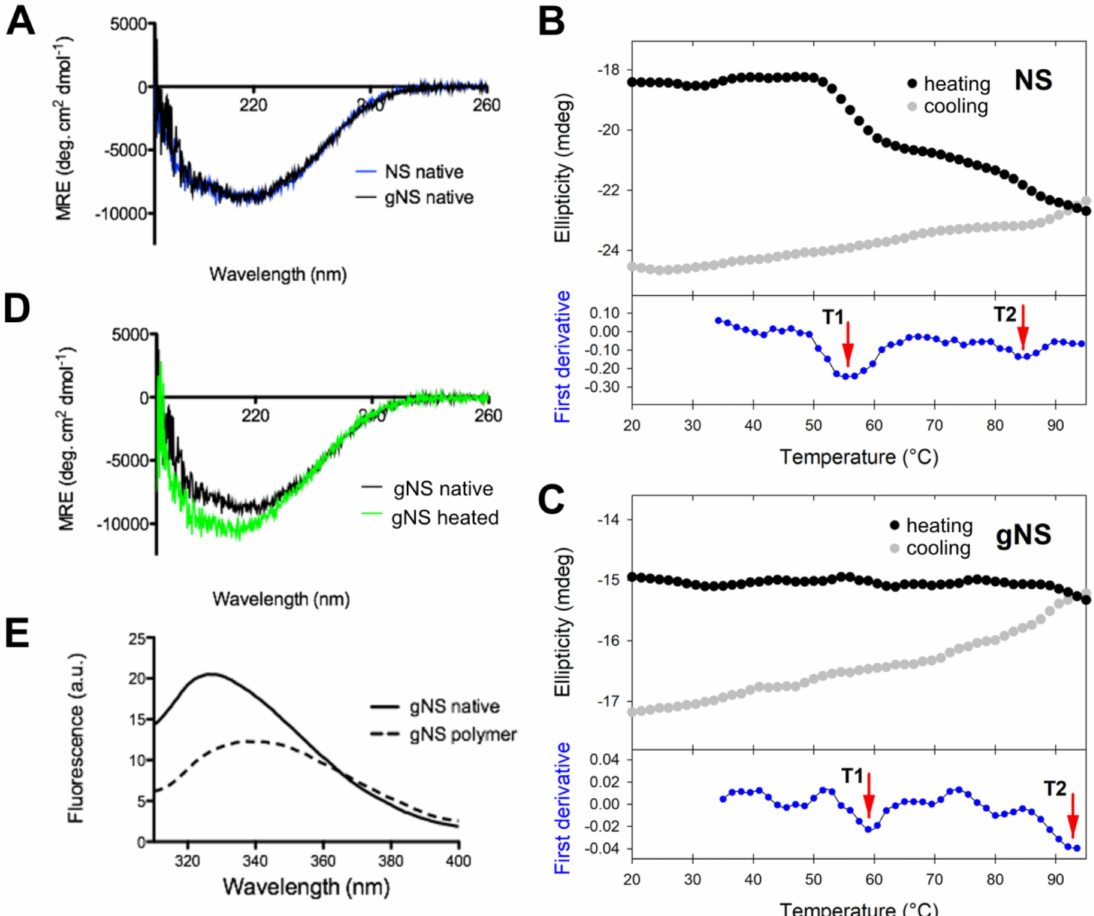
Figure 4. Conformational characterisation of gNS. ( A ) Far-UV circular dichroism (CD) spectra of native gNS and NS recorded at 20 ◦ C. ( B , C ) Temperature ramp of NS ( B ) analogously reported in [24] and gNS ( C ) performed recording ellipticity at 216 nm during heating from 20 to 95 ◦ C (black) and cooling down (grey). The first derivative is reported in the bottom (blue) and the two transitions T1 and T2 are highlighted by the red arrows. ( D ) Far-UV CD spectra of gNS recorded at 20 ◦ C before (black) or after (green) heating the sample to 95 ◦ C. ( E ) Intrinsic tryptophan fluorescence of native (solid line) and polymeric (dashed line) gNS recorded at 20 ◦ C. The bu ff er 20 mM Tris-HCl pH 8, 50 mM KCl was used in all the